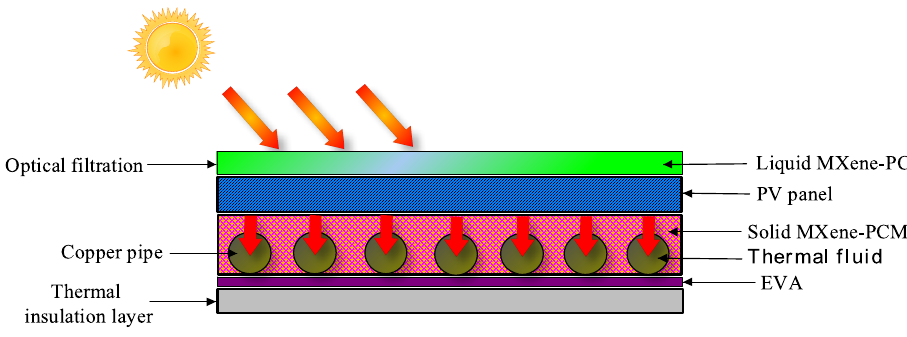
Figure 1. Diagram of PV/T with MXene-PCM module.